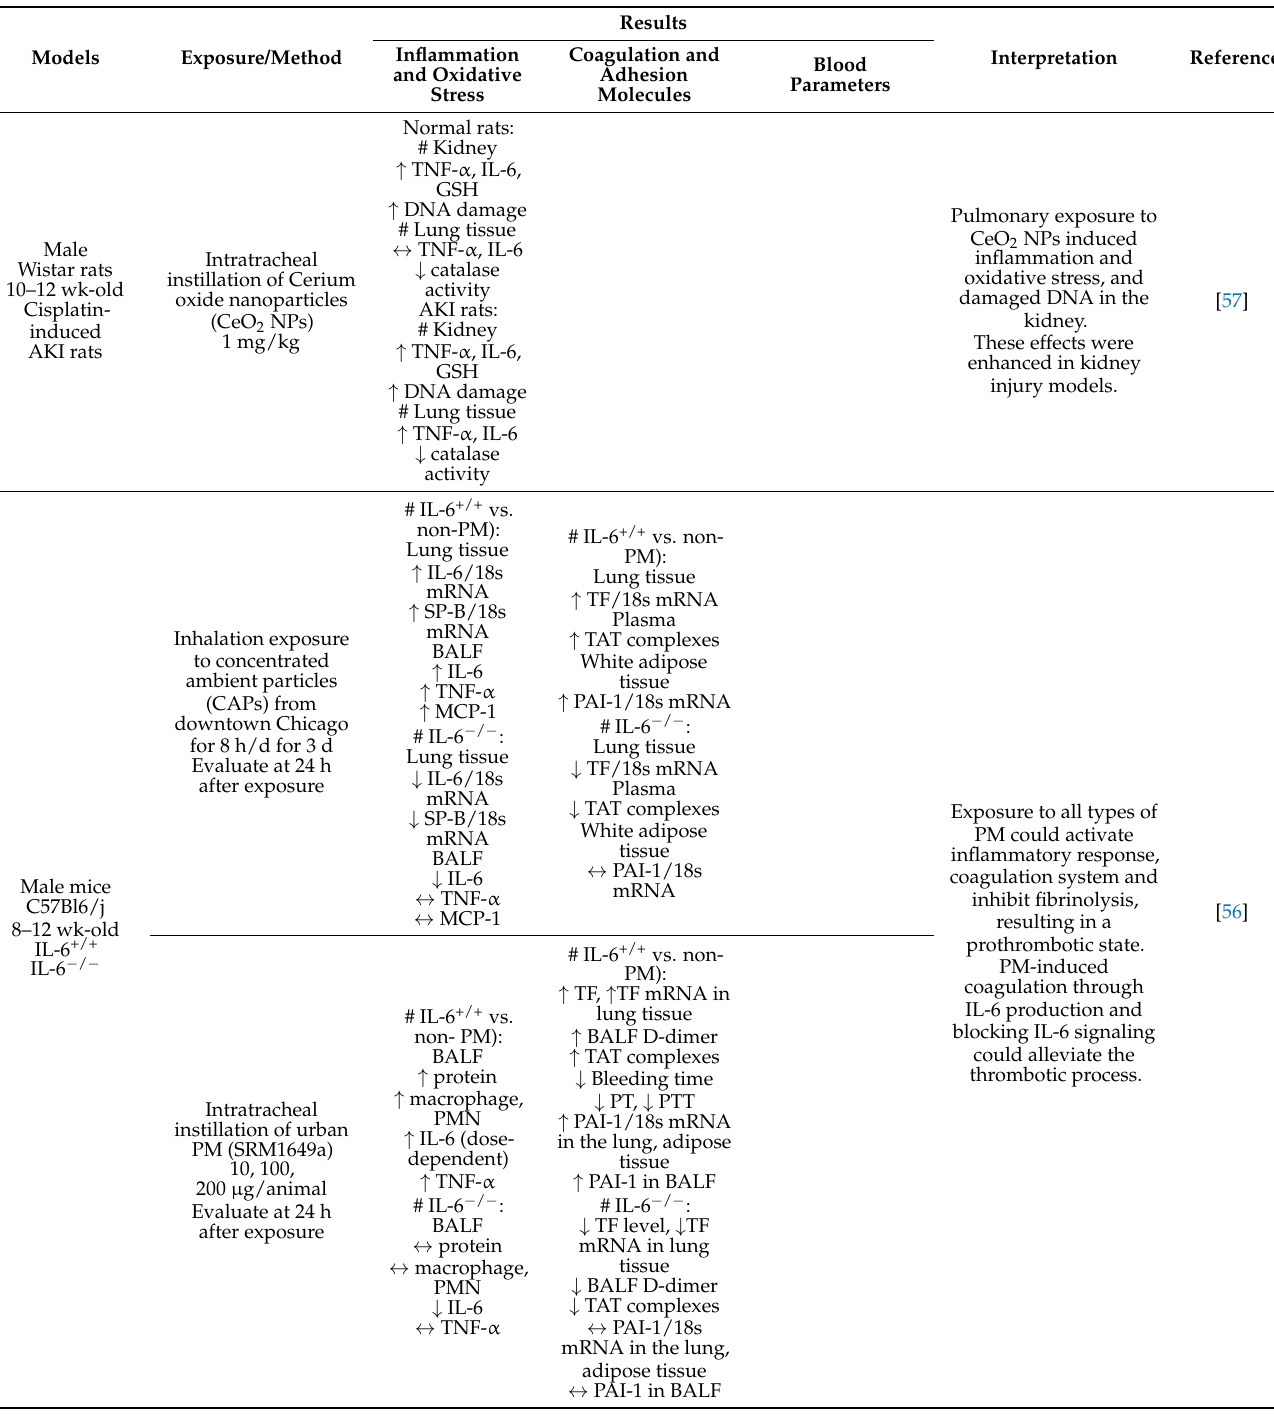
Table 2. The effects of particulate matter on inflammation, oxidative stress, blood parameters, and hemostatic changes: Evidence from in vivo